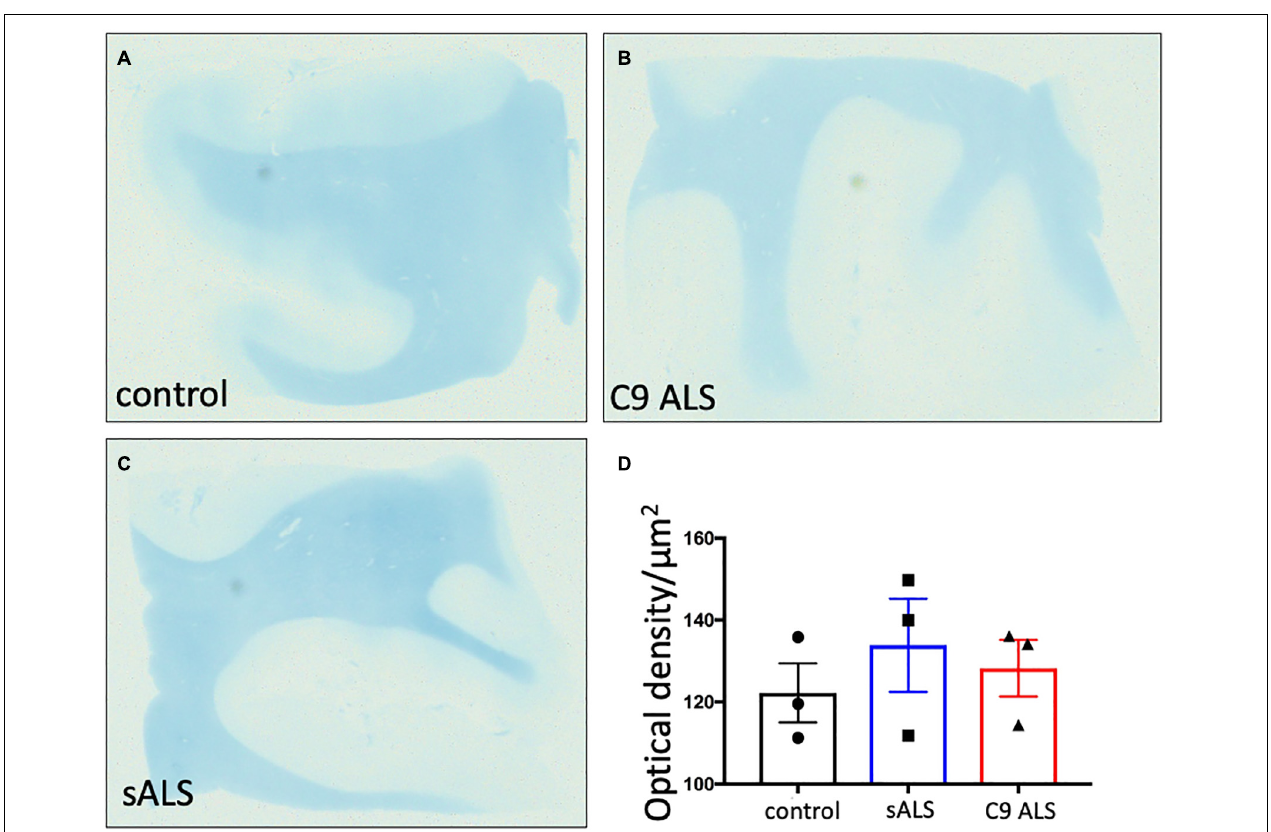
FIGURE 4 | There is no difference in myelin density between groups. (A–C) Representative images of Luxol Fast Blue histological staining of the motor cortex (BA4) showing no difference in staining intensity between groups. (D) Graph showing no difference in the optical density in sALS and C9 ALS patients compared to controls. Optical density was calculated by measuring the average intensity of staining of the entire white matter region per section; a higher optical density correlates to worse